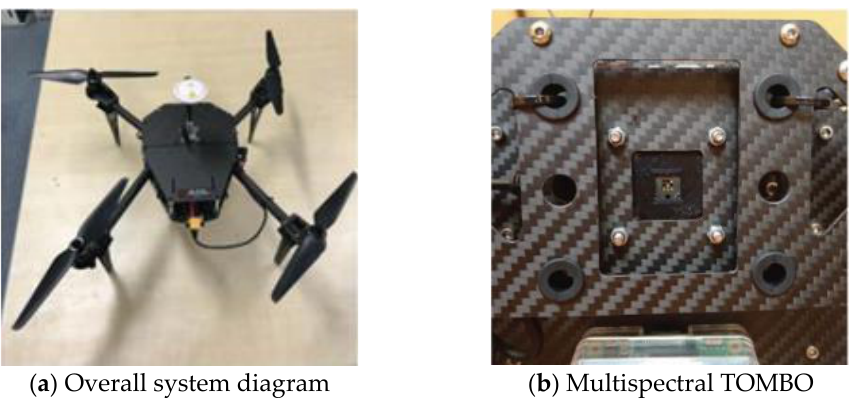
Figure 21. UAV used for the aerial observation: ( a ) overview and ( b ) multispectral TOMBO mounted on the UAV.